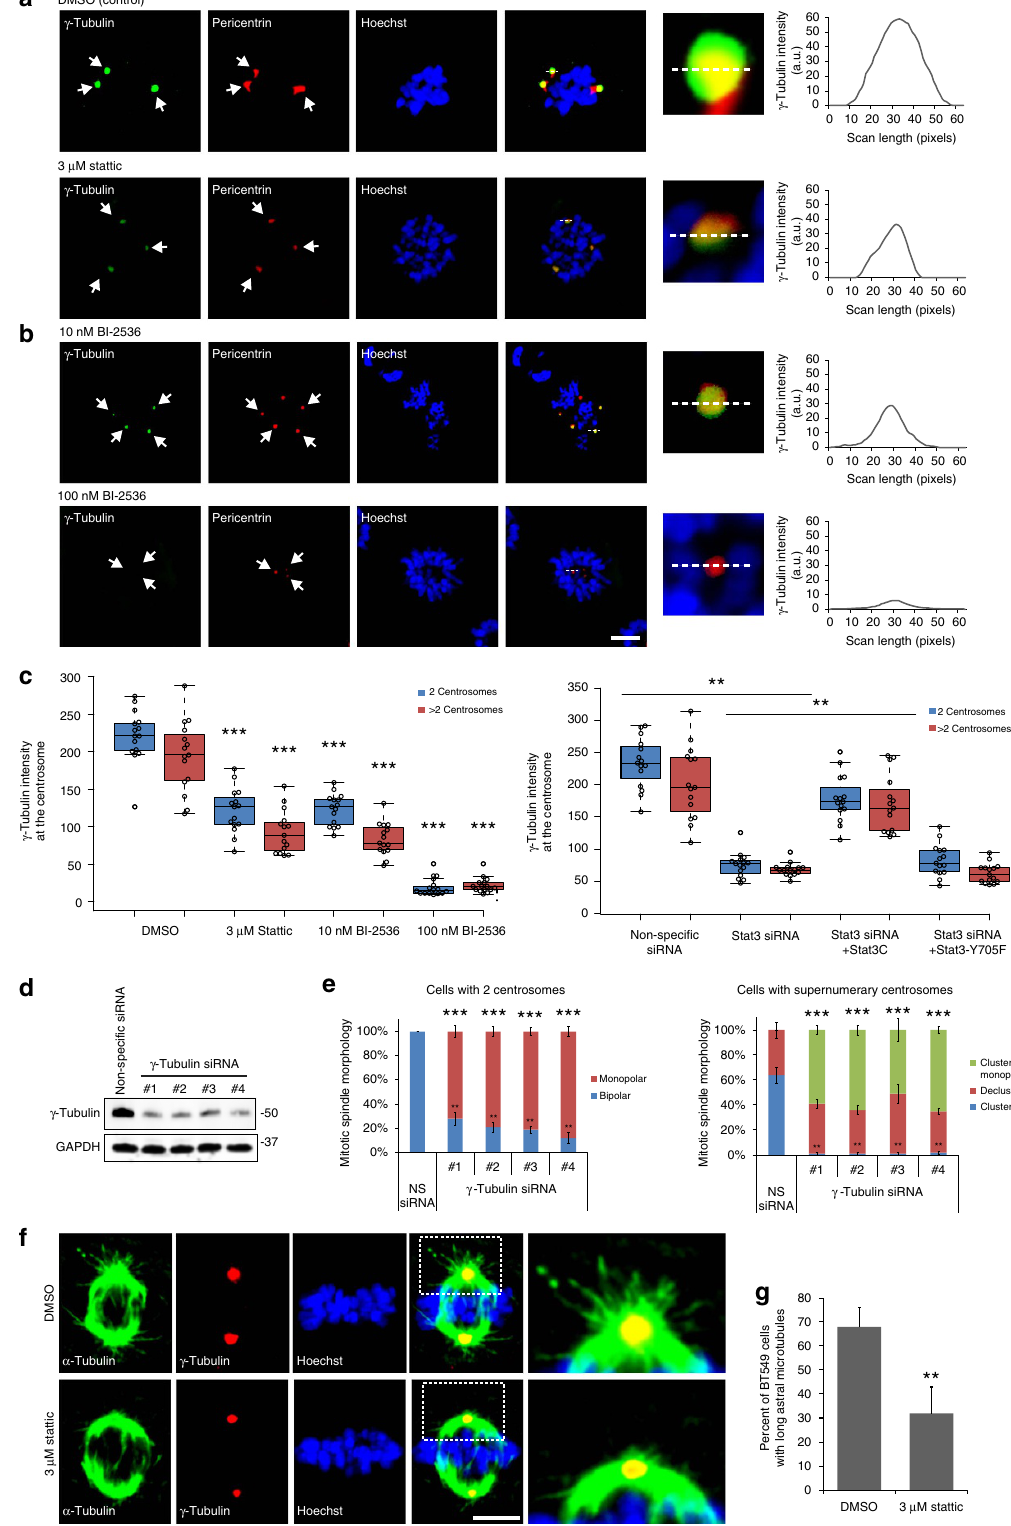
NATURE COMMUNICATIONS|8:15289|DOI: